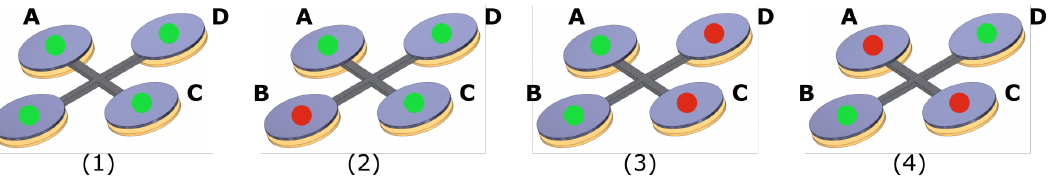
Figure 10. Types of fault scenarios considered in experiments: ( 1 ) no faults, ( 2 ) single damaged rotor, ( 3 ) dual fault, adjacent, ( 4 ) dual fault, opposite actuators.